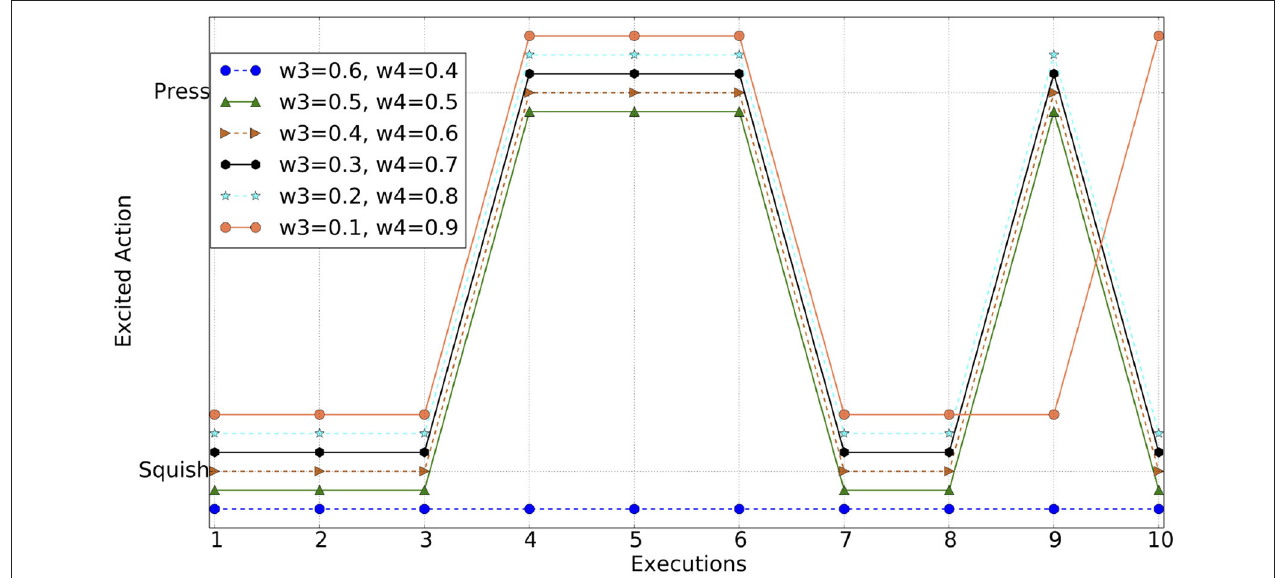
FIGURE 8 | Excited schema action for different values of ω 3 and ω 4 . Lines off-set for visibility.